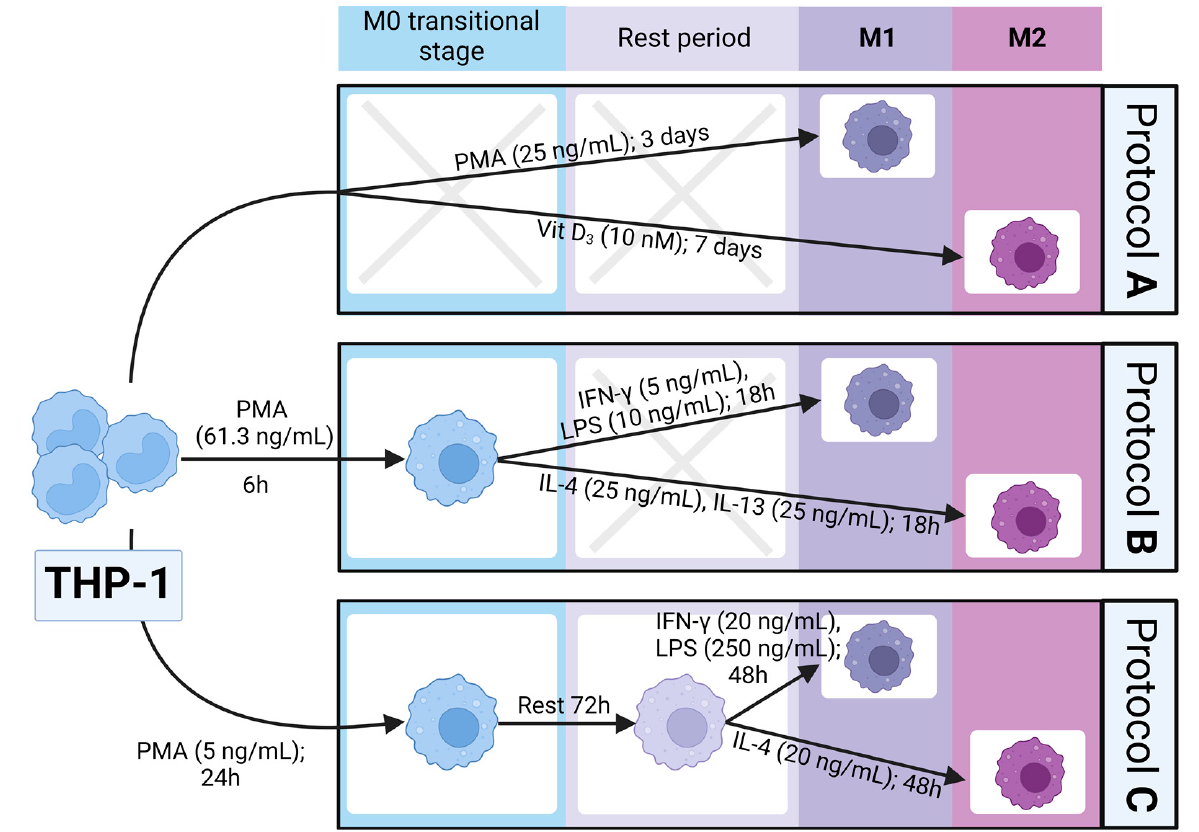
Figure 1. Different polarization protocols of M1 and M2 macrophages. THP-1—(Tohoku Hospital Pediatrics-1 cells) human monocytic cell line; PMA—phorbol 12-myristate 13-acetate; Vit D 3 —1,25-(OH) 2 -Vitamin D 3 ; IFN- γ —interferon gamma; LPS—lipopolysaccharides; IL—interleukin. Created with BioRender.com; accessed on 15 th December 2022.